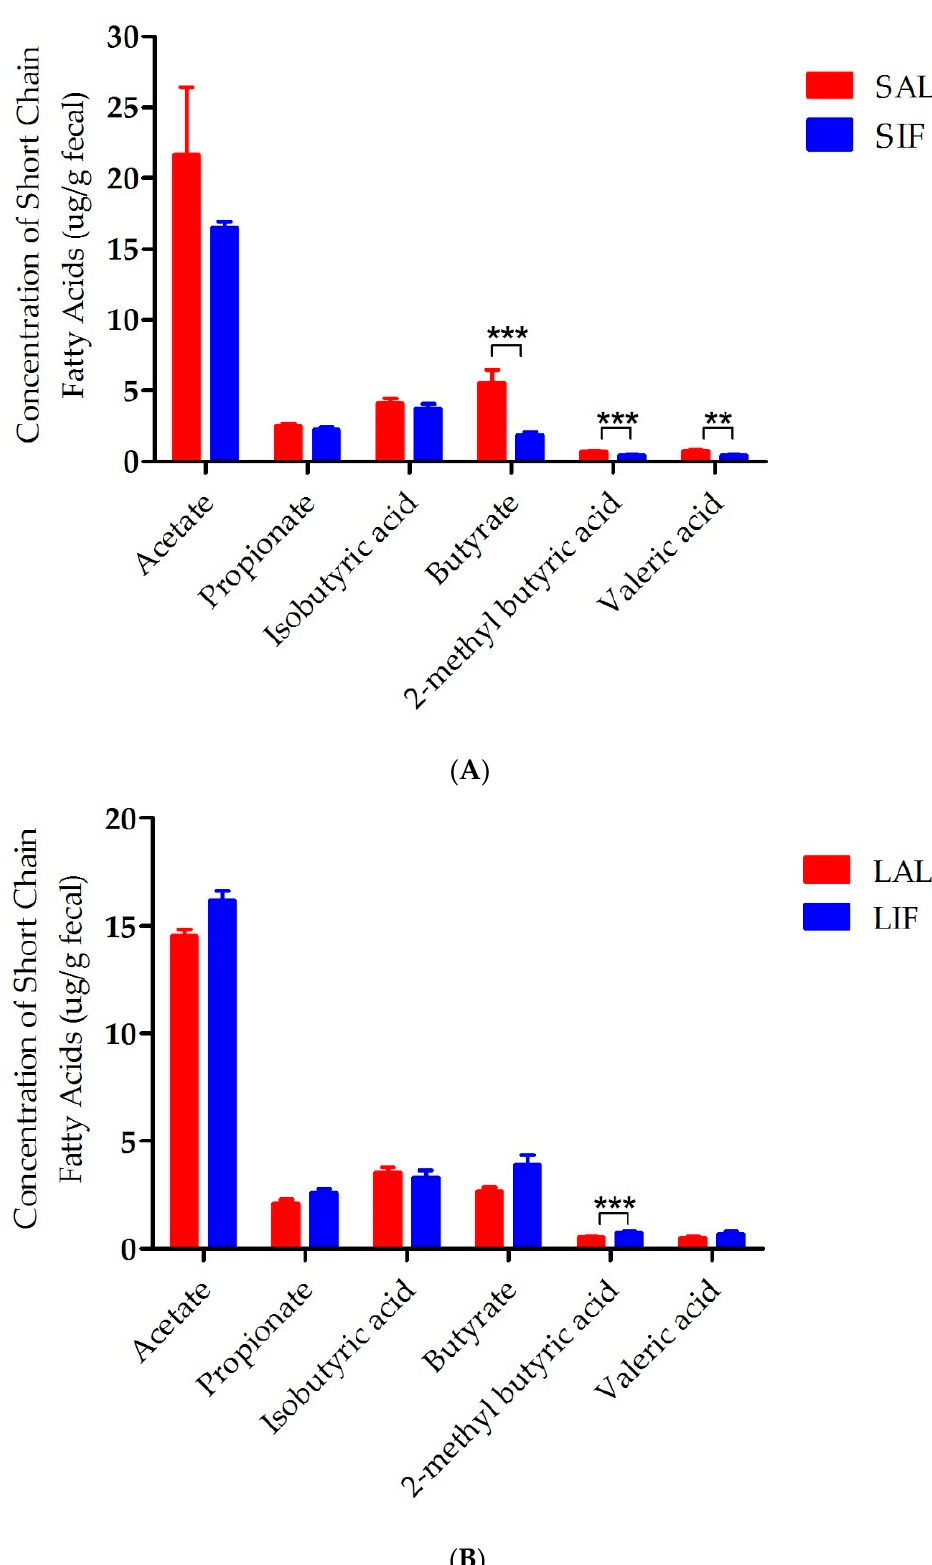
Figure 4. Concentrations of SCFAs in the faeces after IF: ( A ) SCFA concentration in the SAL and SIF groups; and ( B ) SCFA concentration in the LAL and LIF groups. SAL: Short-term of ad libitum-fed group; SIF: Short-term of intermittent fasting group; LAL: Long-term of ad libitum-fed group; LIF: Long-term of intermittent fasting group. p < 0.05, ** p < 0.01, *** p < 0.001.